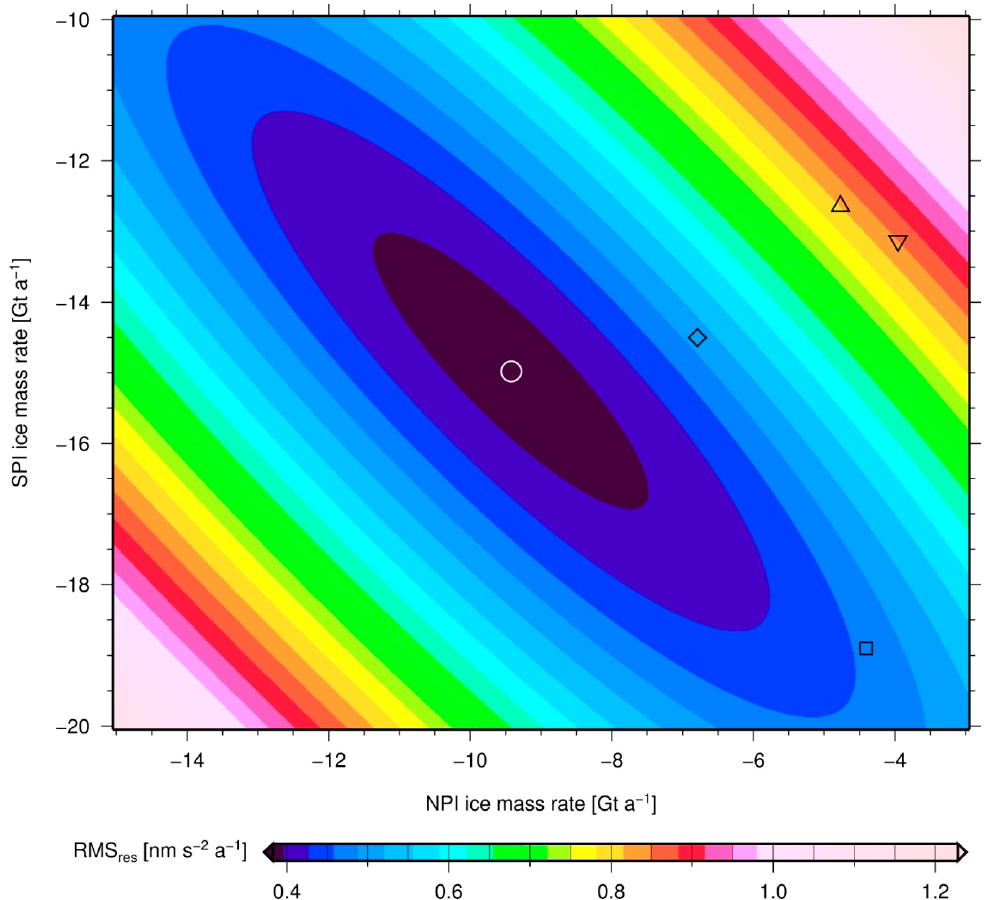
Figure 5. Separation of the ice mass loss at SPI and NPI. After the application of all corrections to the pseudo-observations derived from the GRACE Level-2 data, the residual gravity root mean square (RMS) is computed for pairs of ice mass change rates for SPI and NPI that are varied over plausible ranges. The residual RMS is shown in colors. White circle: ice mass change rates according to our pattern optimization; black symbols: ice mass change rates according to previous works; triangle: Braun et al. [26]; inverted triangle: Jaber [28]; diamond: Foresta et al. [4]; square: Willis et al. [2].